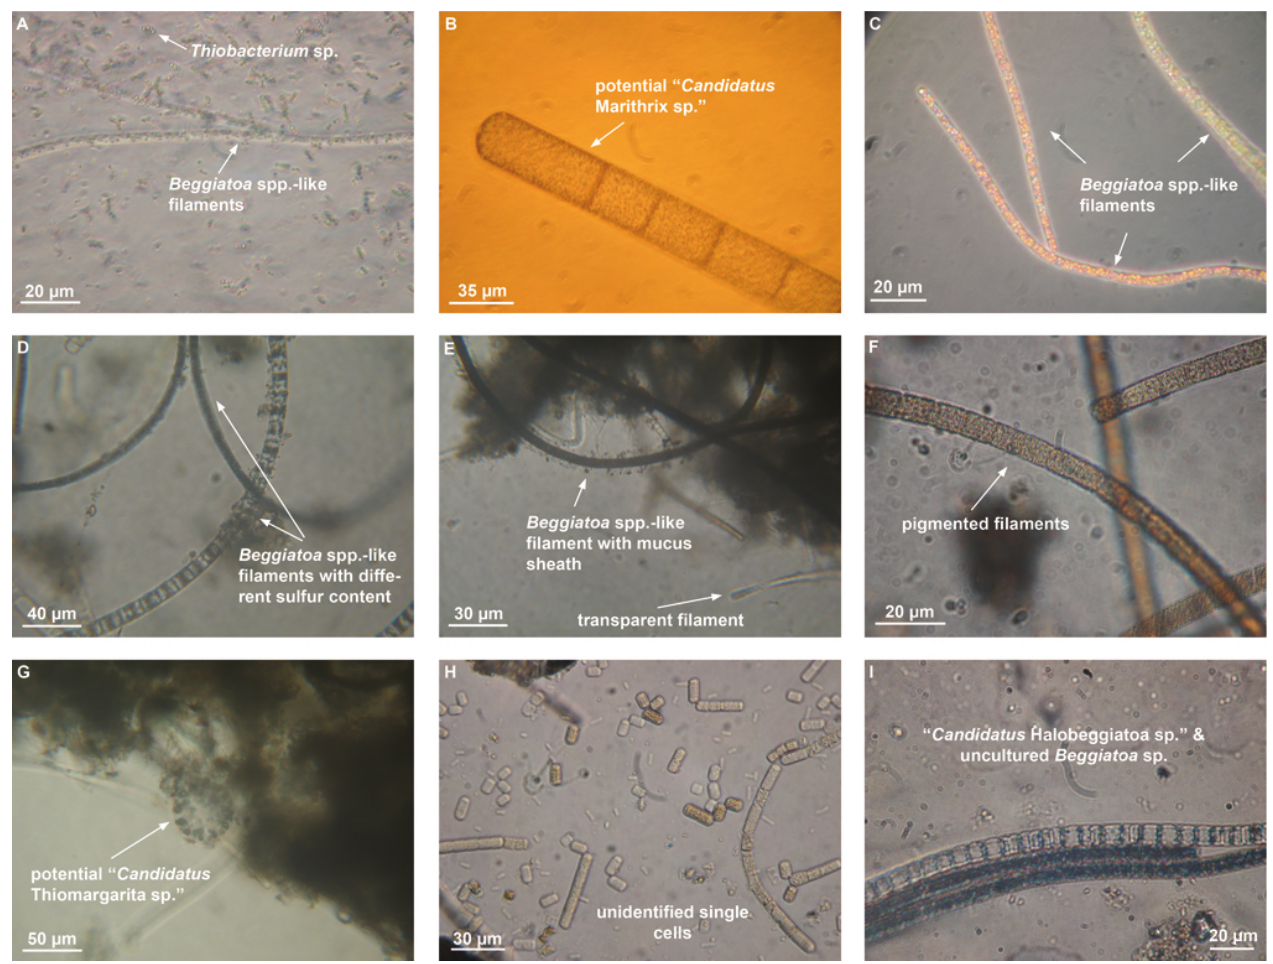
Fig. 2. Mat-forming thiotrophs at deep-sea cold seeps on the Norwegian margin. (A) Filamentous, sulfur-storing bacteria resembling Beg- giatoa spp. at Storegga (cell diameter c.d. ∼ 3–4µm). (B) Filamentous bacteria attached to sediment and tube worms (Storegga), resembling so-called vacuolate-attached filaments, recently classified by Salman et al. (2011) as “ Candidatus Marithrix spp.” (c.d. ∼ 35µm). (C) Sulfur- storing filamentous bacteria at Nyegga resembling Beggiatoa types (c.d. ∼ 3µm). (D, E) Different types of filamentous bacteria resembling Beggiatoa in H˚akon Mosby mud volcano (HMMV) gray mats (c.d. up to 10µm). (F) Unidentified, pigmented filaments (HMMV gray mats; c.d. ∼ 7µm). (G) Single “ Candidatus Thiomargarita sp.” with a cell diameter of 50µm (HMMV gray mats). (H) Unidentified single cells (HMMV gray mats; c.d. up to 8µm). (I) Two types of Beggiatoa spp.-like filaments observed within HMMV white mats (“ Candidatus Halobeggiatoa spp.” and uncultured Beggiatoa spp.; c.d.